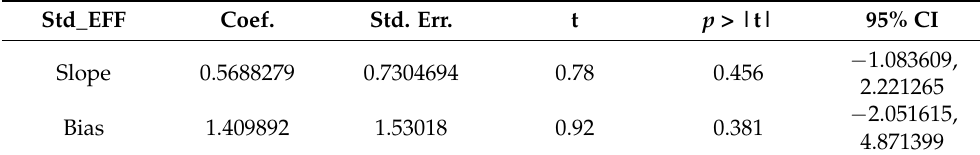
Table 2. Methodological assessment of randomized controlled trials included in the systematic review using the PEDro scale.